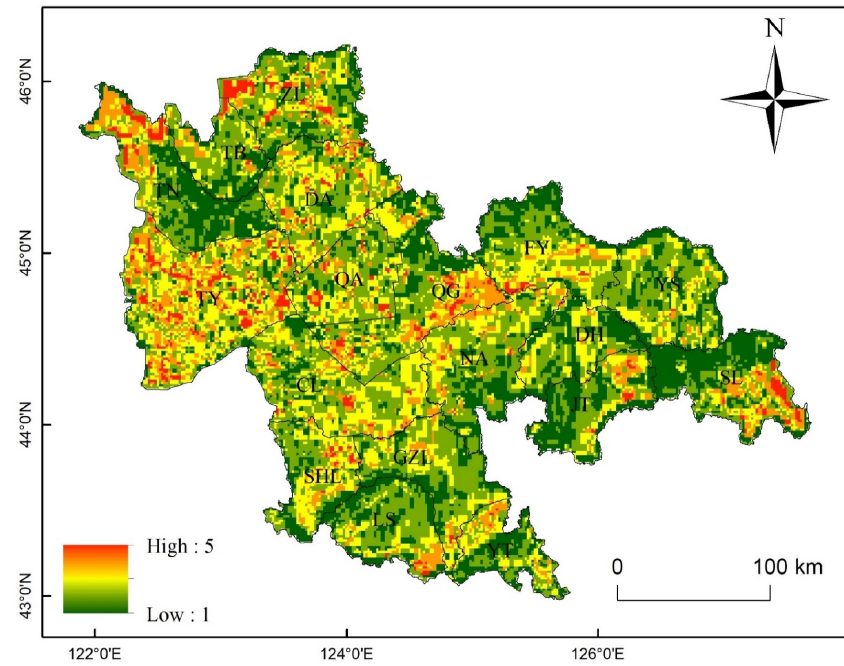
( d ) Figure 10. Distribution of different disaster-pregnant environmental factors: ( a ) distribution of topo- graphic position index (TPI) levels; ( b ) distribution of vegetation cover levels; ( c ) distribution of soil